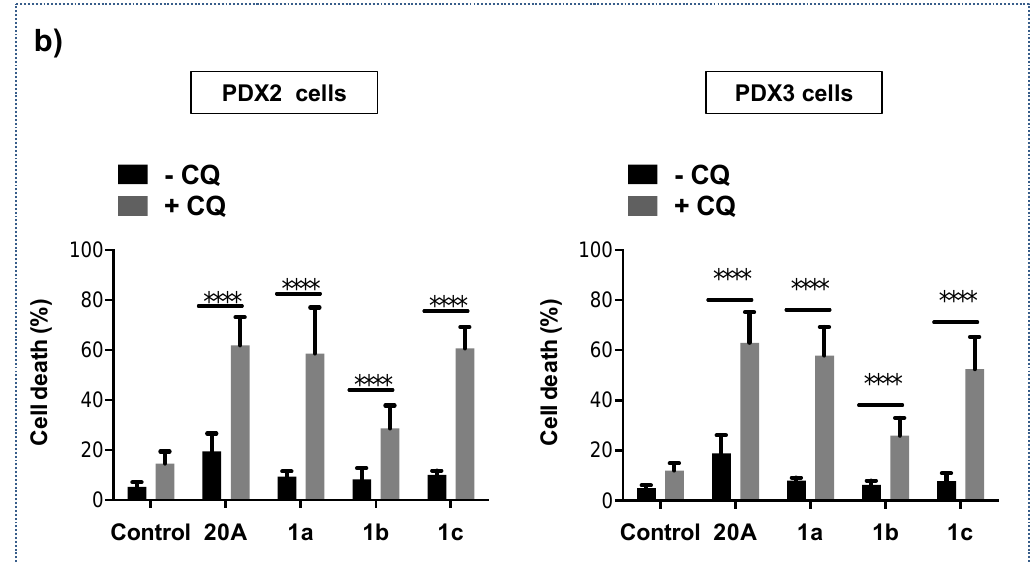
Figure 7. Combination of chloroquine with 20A derivatives significantly enhances cell death in both A549 lung cancer cells and patient – derived xenograft cell lines from lung cancer. A549 lung cancer cell lines ( a ) and two PDX from lung cancer PDX2 and PDX3 ( b ) were treated with either 3.5 µM 20A , 2.5 µM 1a, 1.5 µM 1b or 2 µM 1c in the presence and absence of 25 µM chloroquine for 24h. Cell death was evaluated by scoring the percentage of propidium iodide positive cells by flow cytometer analysis. The data represents the mean ± SD of 9 values obtained from three independent experiments each performed in triplicate ( p- value *** < 0.001 and **** < 0.0001 using Mann-Whitney test).